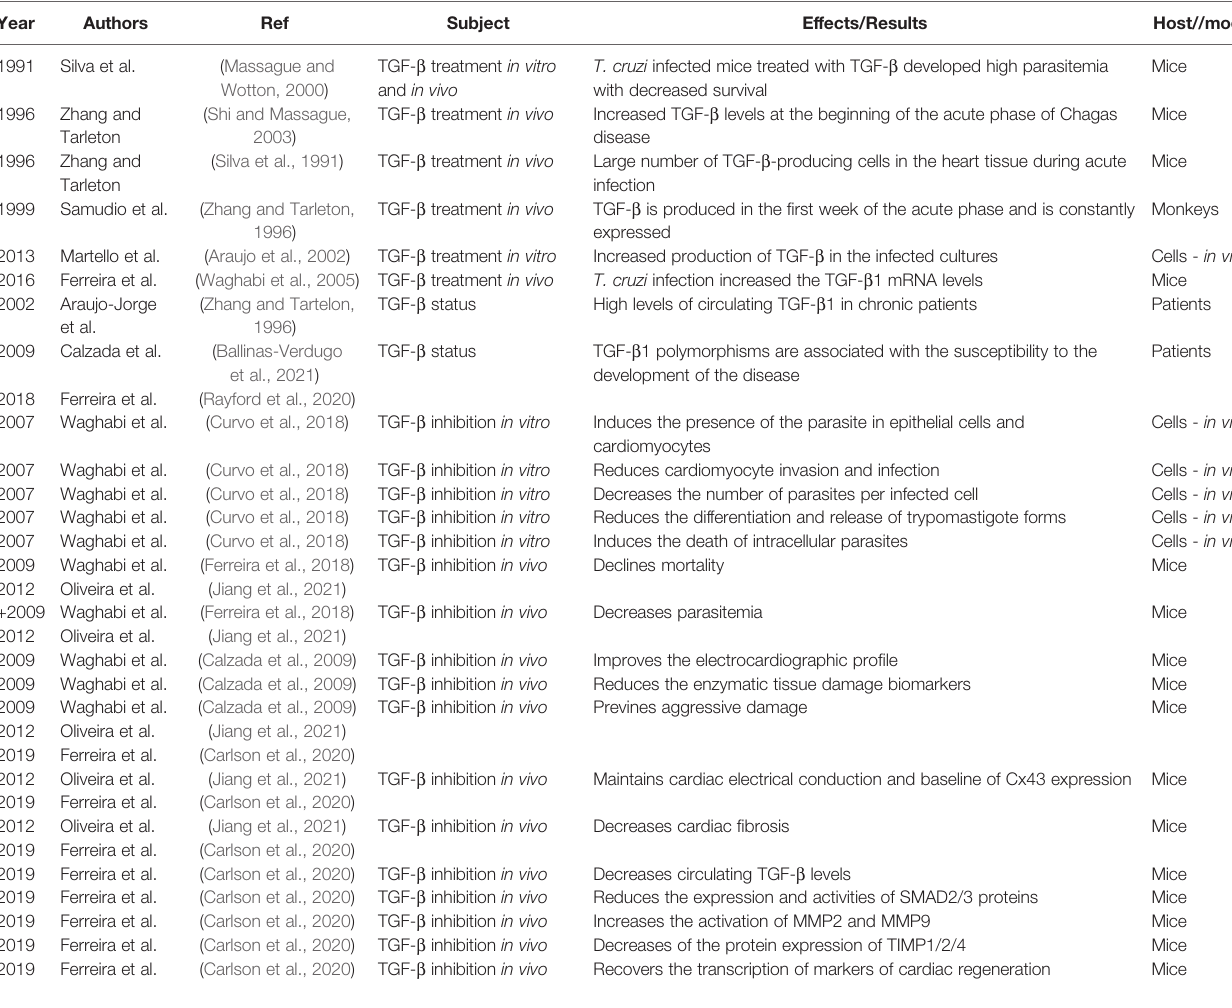
TABLE 1 | Pre-clinical and clinical approaches implicating TGF- b in modulation of pathology in Chagas